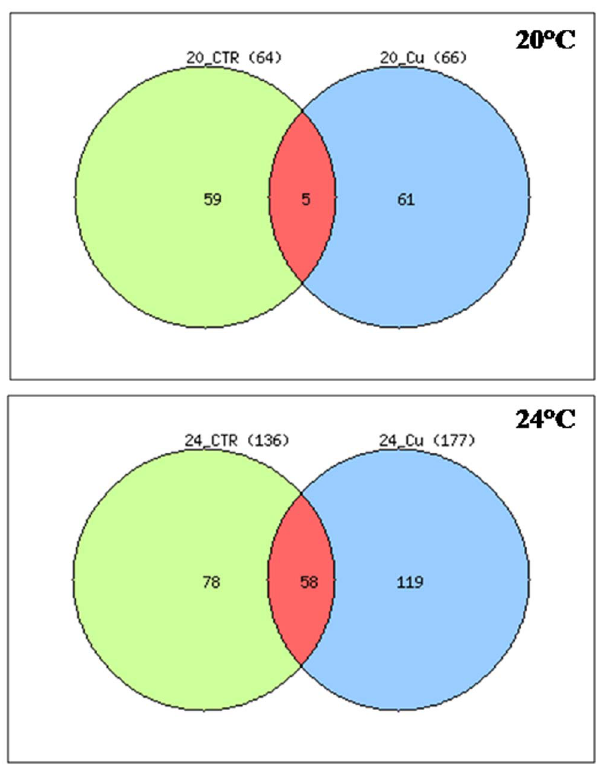
Figure 5. Venn diagram representation of gene expression patterns. The diagram clearly depicted that only 5 DEGs shared between 20 u C and 20 u C plus Cu and 58 DEGs between 24 u C and 24 u C plus Cu. All DEGs are obtained respect to the control condition 16 u C.Data used to generate the Venn-diagram were obtained from microarray analysis (Table S3).